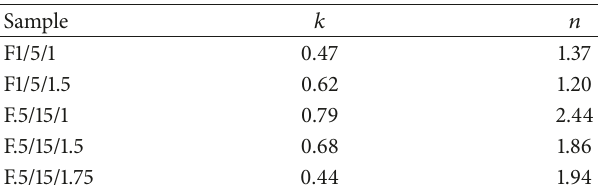
Table 3: k and n values in Weibull equation for ibuprofen release from